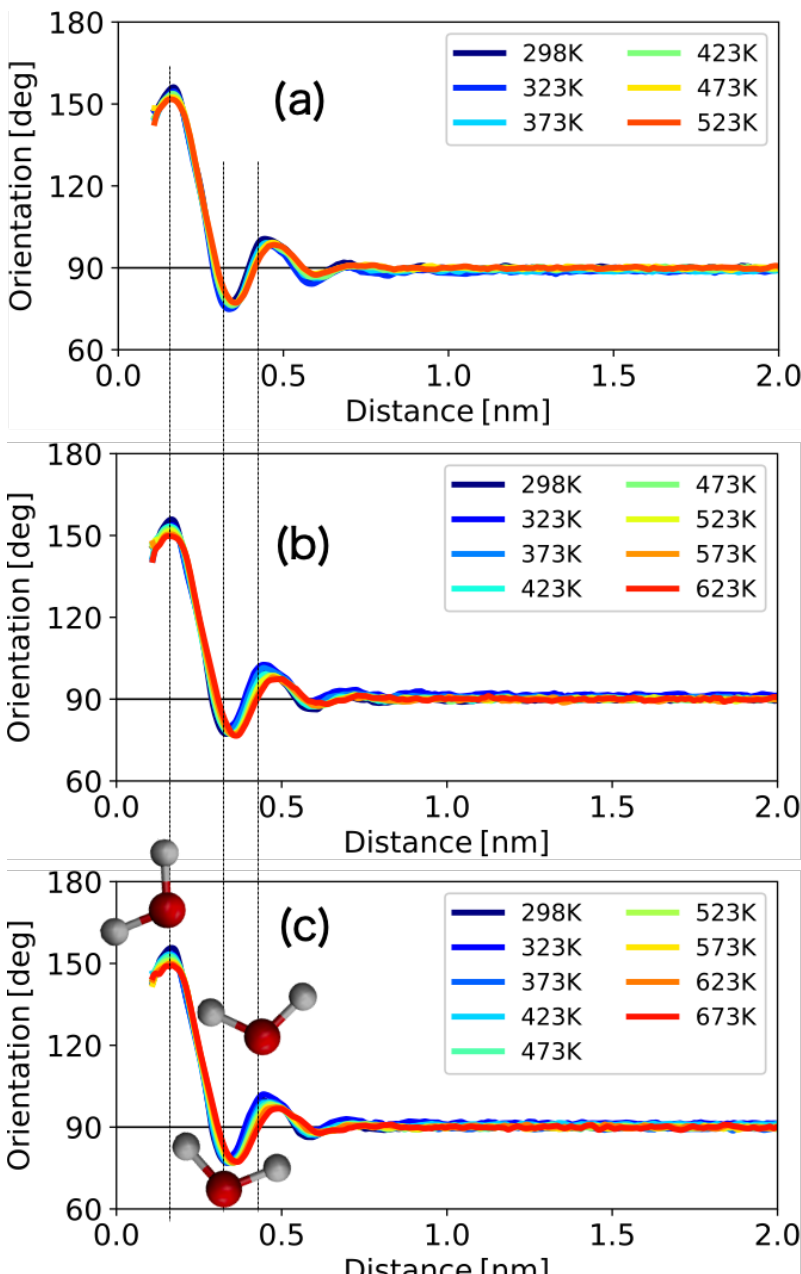
Figure 8. Profiles of the orientation angle 𝜃 of H 2 O molecules from the muscovite surface at ( a ) 0.1 MPa ( b ) 10 MPa ( c ) 50 MPa; a snapshot of a H 2 O molecule at each of three extreme values of 𝜃 is shown.